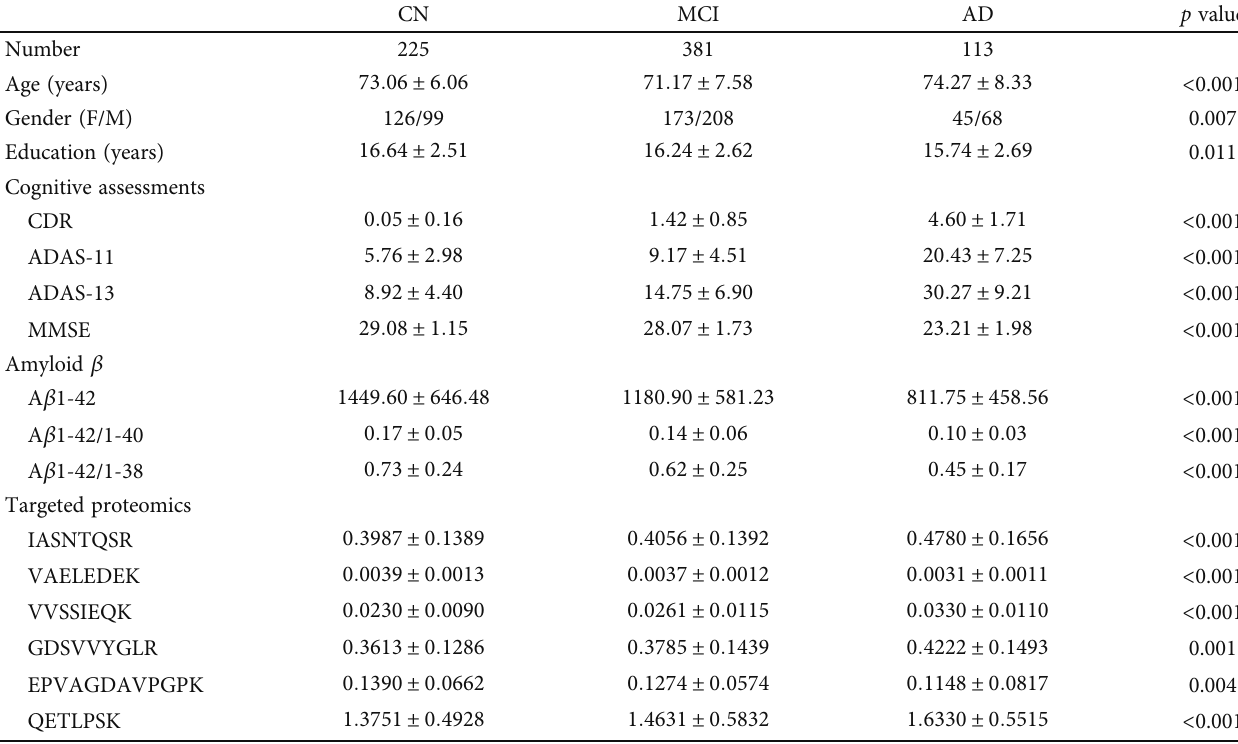
Table 2: Demographics and clinical characteristics of the study population.